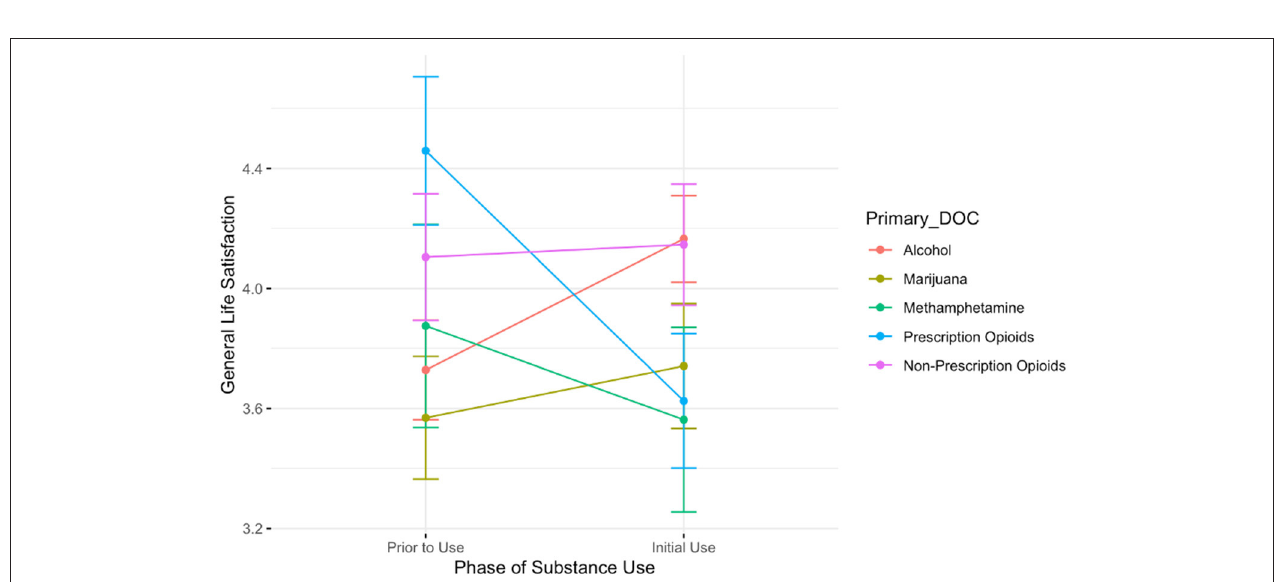
FIGURE 4 | A plot showing the average romantic satisfaction scores for participants during the initial stages of use, the height of problematic use, and during the initial stages of cessation. Lines are colored by participant primary substance of choice. Those who use non-prescription opioids report lower satisfaction than those in other groups during the initial period of cessation. We also generally see a “V”-shaped pattern among those who used alcohol and prescription opioids, where romantic satisfaction is lowest in the height of problematic use. However, for those who used methamphetamine and non-prescription opioids, romantic satisfaction continues to decrease from the height of problematic use to the initial cessation period.